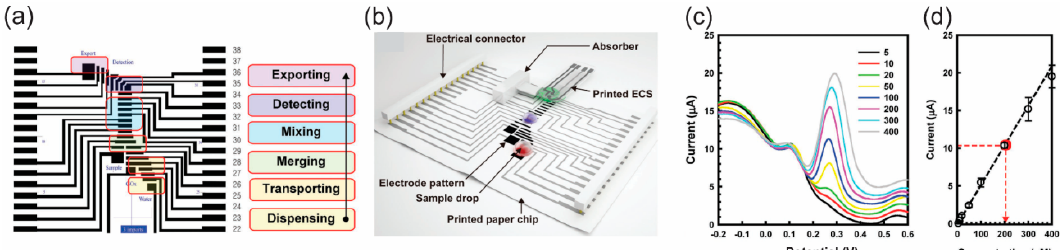
Figure 19. Electrochemical detection by using a p-DMF chip. ( a ) Programming sample delivery on the chip for assay protocols. ( b ) Schematic illustration of a p-DMF chip with an electrochemical sensor. ( c ) Electrochemical signal received from uric acid of various concentrations and ( d ) the calibration curve. Reprinted with permission from the authors of [28]. Copyright 2017 WILEY-VCH Verlag GmbH & Co. KGaA, Weinheim.